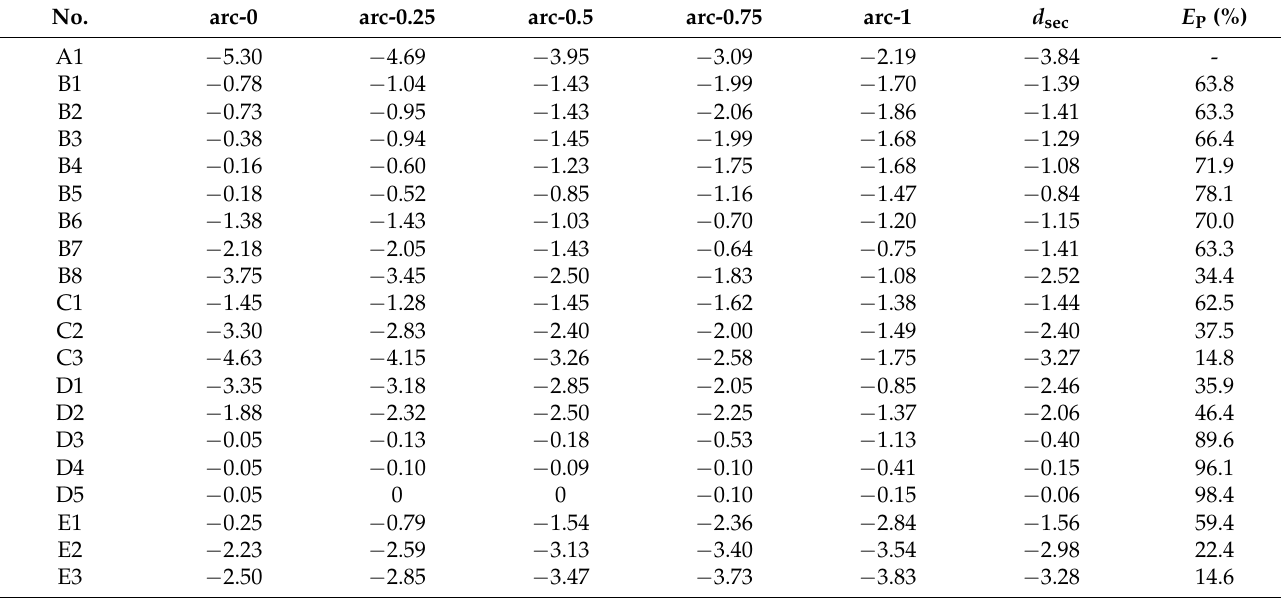
Table A1. Average scour depth around the pier